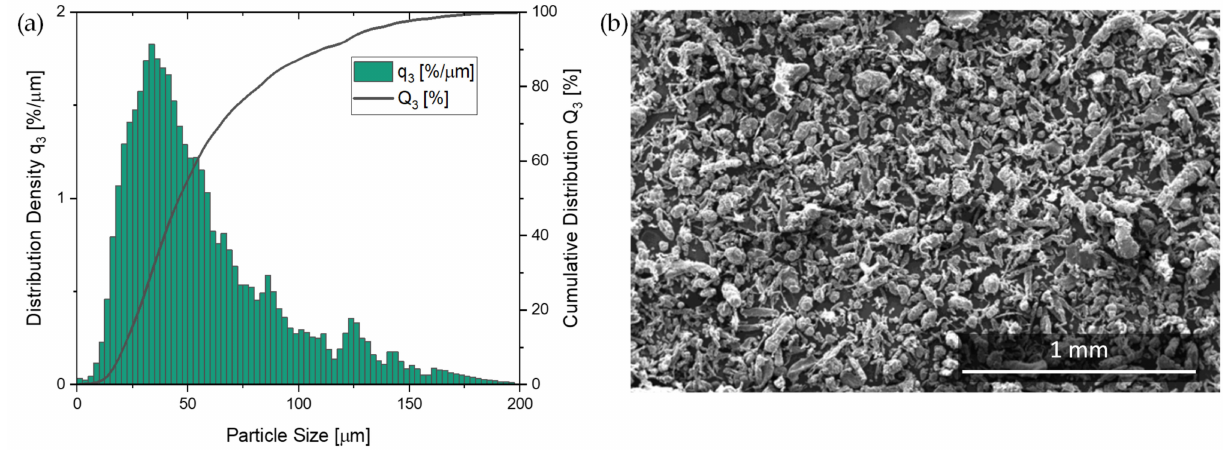
Figure 3. ( a ) Volume-based particle size distribution of sieved and dried PET powder; ( b ) SEM picture of PET powder particles used for